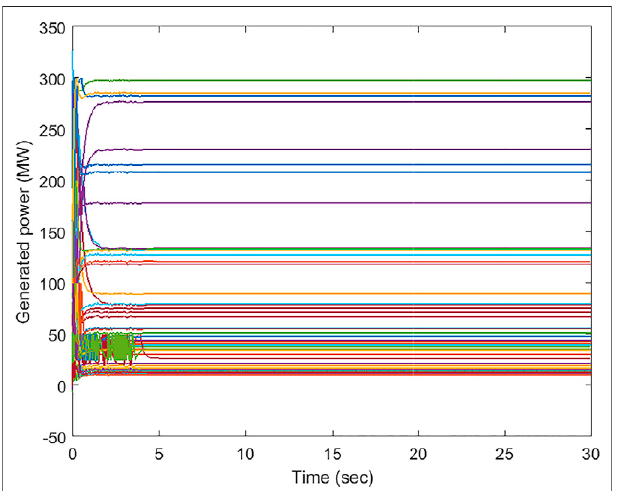
FIGURE 13 | Total generation using the proposed approach for IEEE- 118 bus